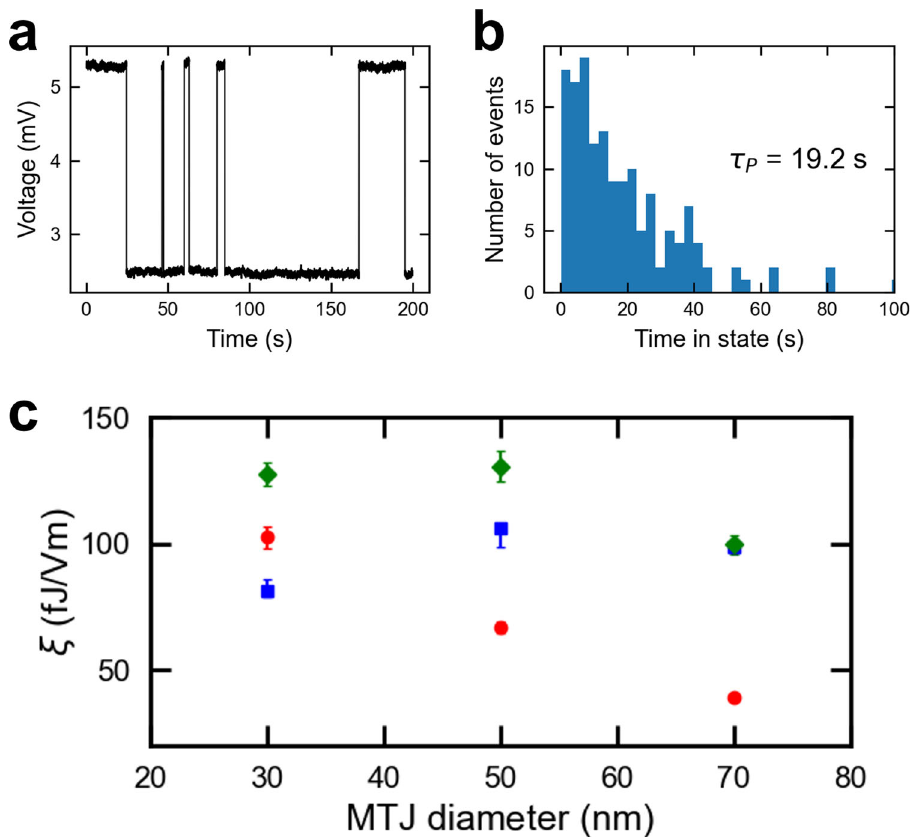
Fig. 4 Characterization of free layer energy barrier and VCMA coef fi cients. a Real-time voltage measured for near-zero bias across the 70 nm MTJ, under the same applied fi eld used for the switching measurements in Fig. 3. b Distribution for parallel state dwell times for the same device. c Red dots: VCMA coef fi cients obtained from the switching voltages. Error bars represent the uncertainty in the energy barrier measured from the dwell time. Blue squares: VCMA coef fi cients obtained from the switching voltages, using the effective MTJ area for each diameter (See Supplementary Note 5 for details). Error bars represent the uncertainty in the energy barrier measured from the dwell time, and the fi tting parameters used to estimate the effective area. Green diamonds: VCMA coef fi cients obtained from the voltage-dependent energy barrier measurements (See Supplementary Note 5 for details). Error bars represent the uncertainty in the energy barrier measured from the dwell time, and the fi tting parameters used to estimate the effective